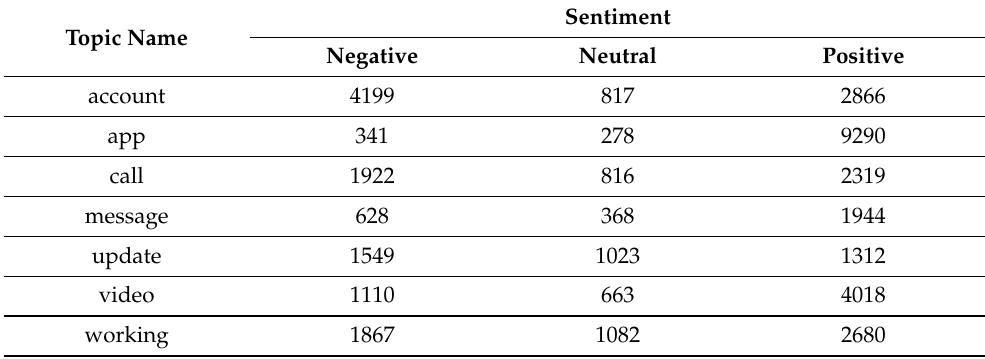
Table 6. Sentiments against